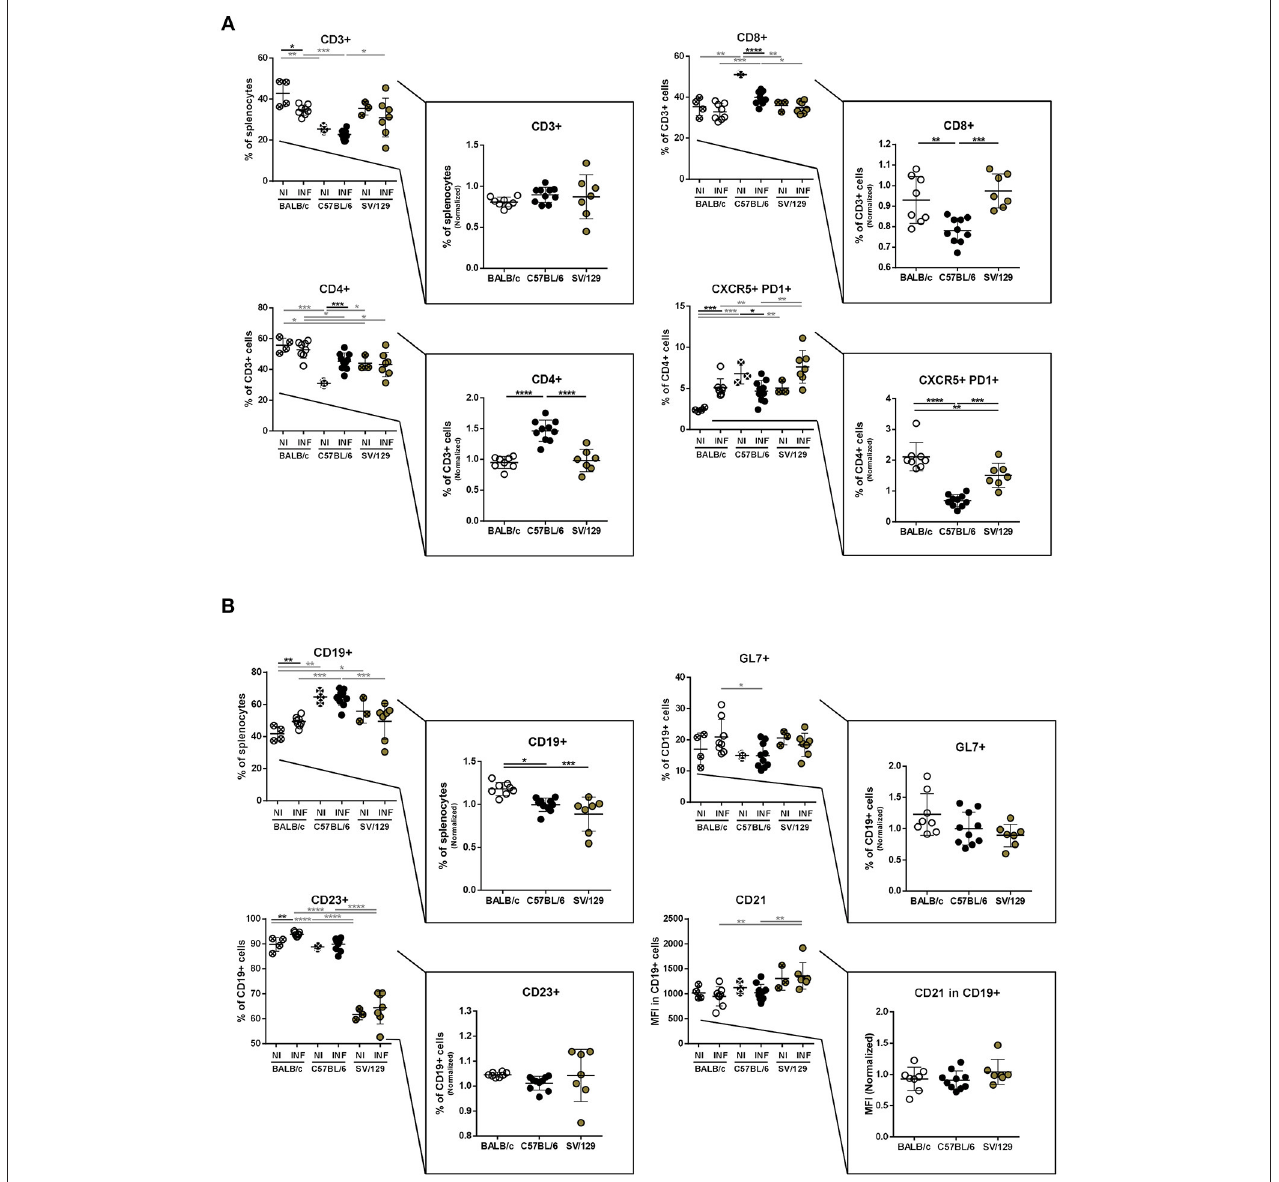
FIGURE 3 | Splenic lymphoid compartment of the different mouse strains and it’s alteration 8 weeks post L. infantum infection. BALB/c (white circles), C57BL/6 (black circles), and SV/129 (brown circles) mice were infected intraperitoneally with 1 × 10 8 L. infantum promastigotes and euthanized 8 weeks after. Splenic lymphoid populations were resolved by flow cytometry: T cell (A) and B cell (B) compartments. Results, obtained in at least two independent experiments, are represented both in total percentages (infected and control animals) and normalized (infected in relation to control group average values) as a way to highlight the infection-induced alterations. Each dot represents an animal. Average and SD of the values within each group are shown. Statistical differences are properly identified. One Way ANOVA (with Tukey’s post-hoc analysis) was used for comparisons between the different murine strains (infected or non-infected; gray lines), as well as for comparison of normalized values (black lines); t -tests (black lines) were performed for comparison between infected animals and controls from the same strain: * p ≤ 0.05, ** p ≤ 0.01, *** p ≤ 0.001, and **** p ≤ 0.0001).